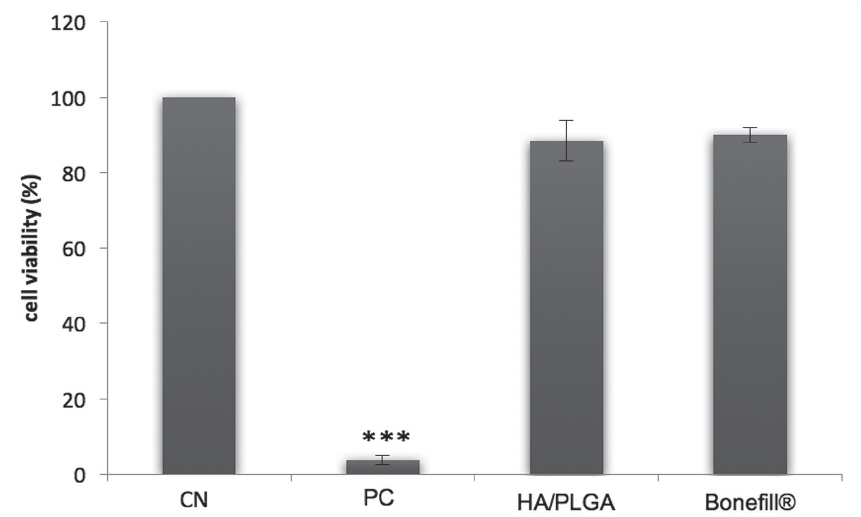
FIGURE 1 - XTT assay in CHO-K1 (Cell viability). Cells treated with 100% concentration HA/PLGA and Bonefill ® eluates. NC: negative control; PC: positive control. NC represents 100% cell viability. Columns = mean of cell viability (%); bars = Standard error. *** = p<0.0001 compared to NC; Dunnett’s